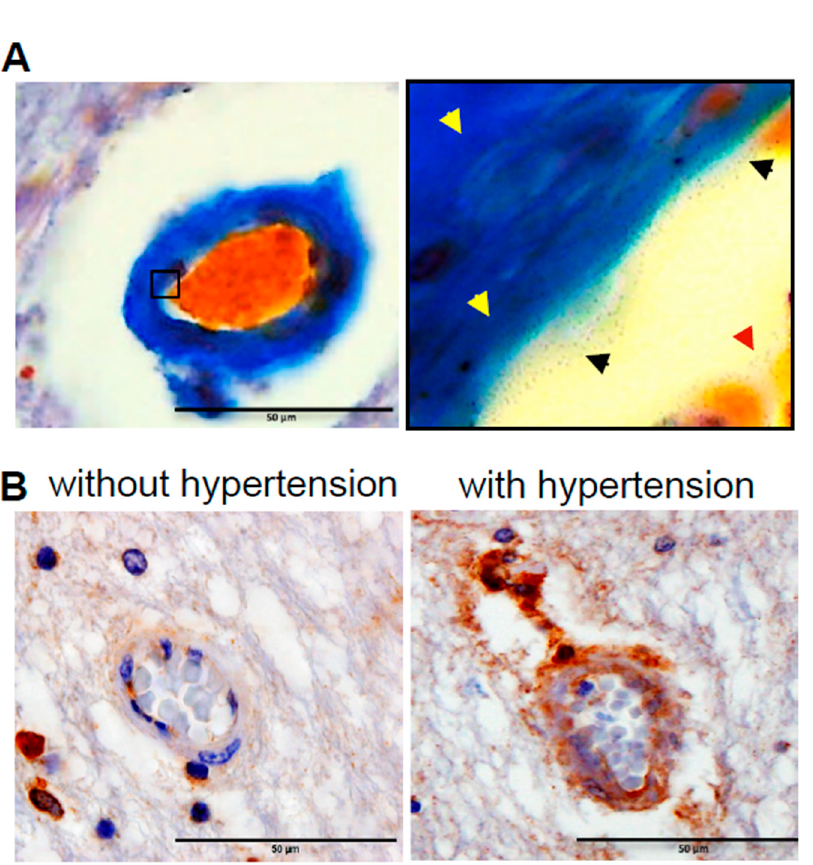
Figure 1. Vascular hyalinosis in systemic hypertension patients who died of ischemic stroke. ( A ) Representative Zerbino–Lukasevich staining of patients with systemic hypertension who died of ischemic stroke. The left panel shows the infiltration of plasma fibrin into the vessel wall. The right panel (magnified, × 1000) shows the fibrin in the blood, at the vessel surface, and in the vessel wall. ( B ) Representative immunohistochemistry results using the ApoE antibody in patients who died of ischemic stroke without hypertension or with hypertension. Positive ApoE stains in the intima, media and adventitia layer were found only in the with hypertension group. Magnifications, × 400. Scale bars, 50 µ m. Representative images of N = 8 patients per group.